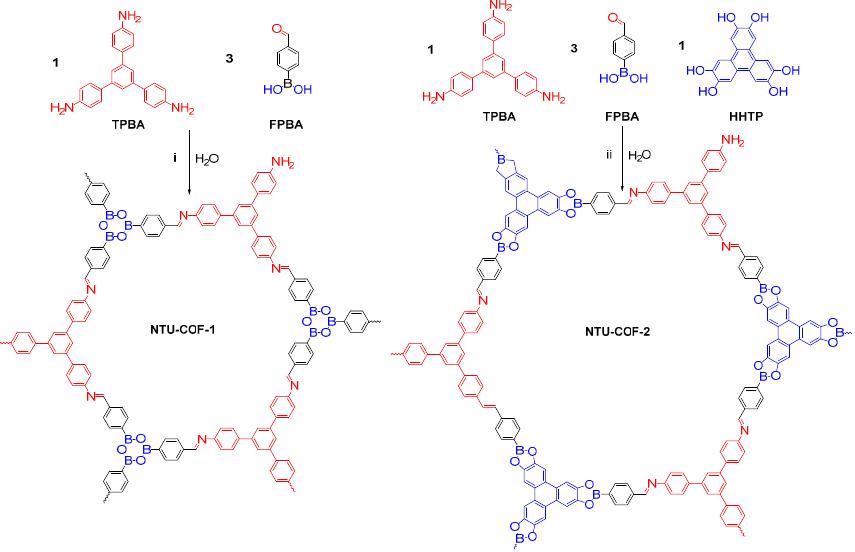
Figure 25. Syntheses of (i) NTU-COF-1 and (ii) NTU-COF-2 by two types of covalent bonds from orthogonal reactions.